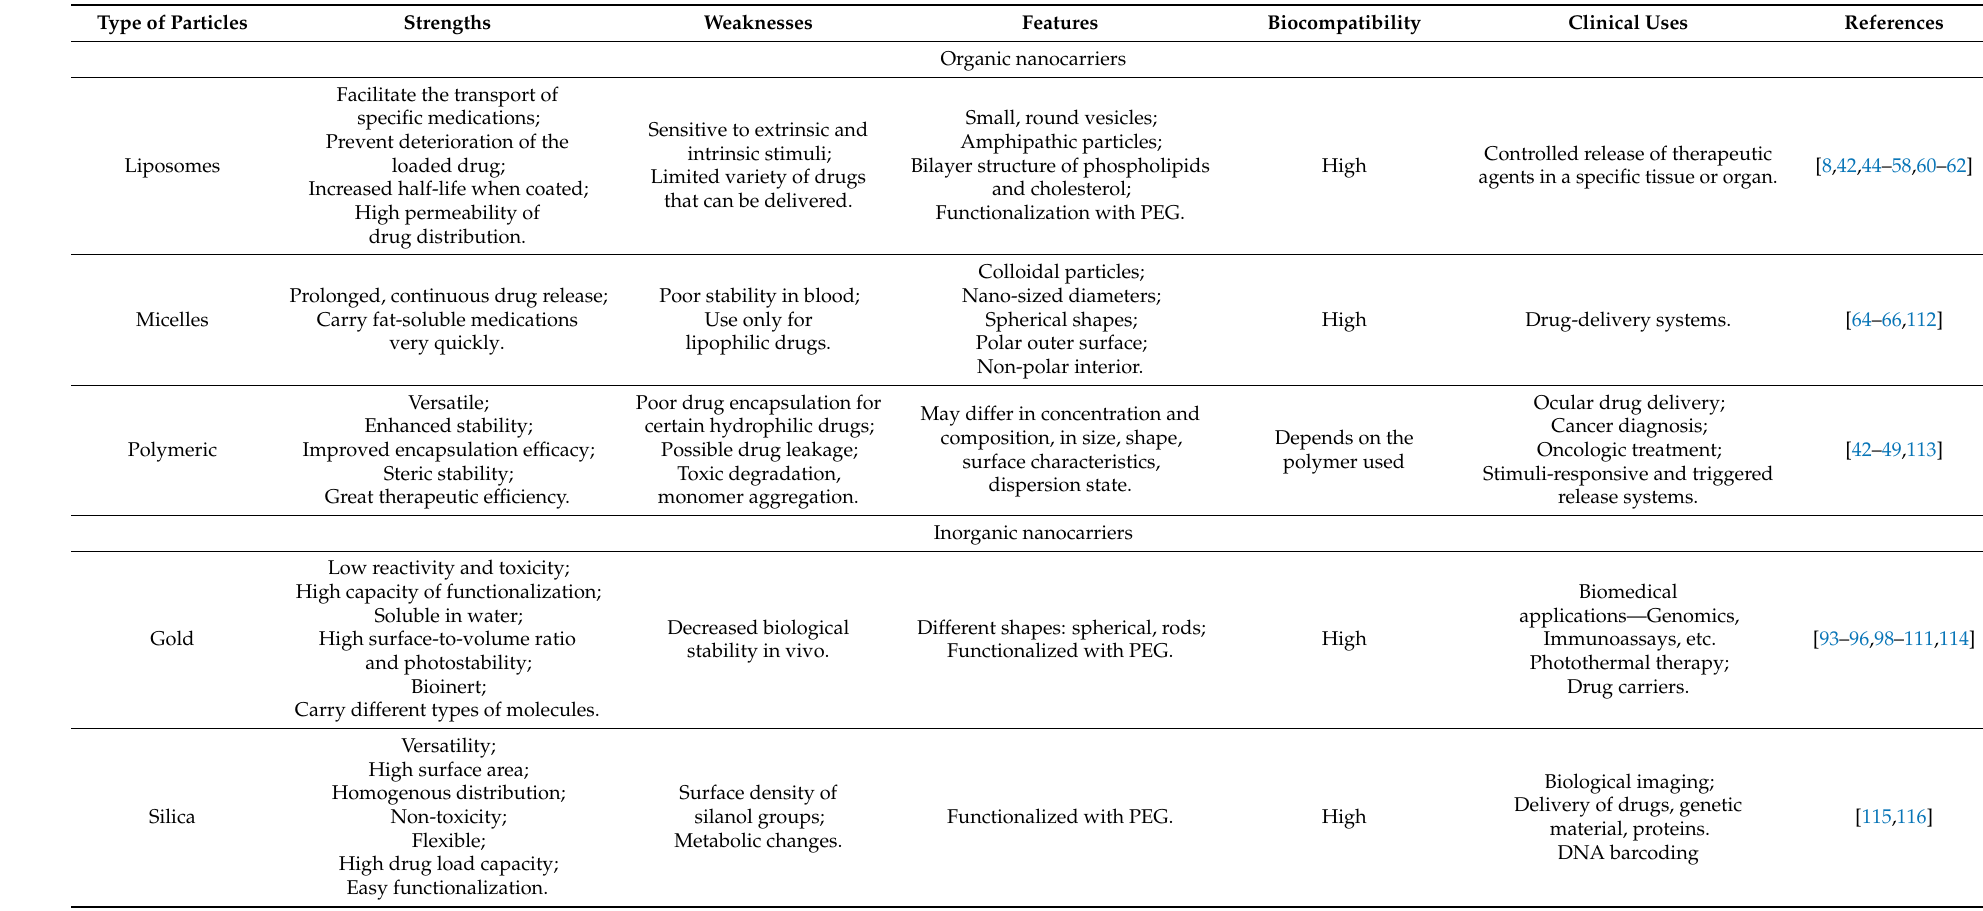
Table 1. A brief overview of organic and inorganic